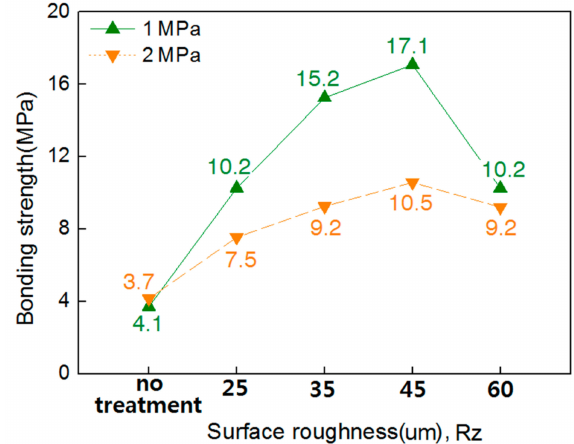
Figure 8. Bonding strength of CFRP/CR980 hybrid composites with different surface roughness conducted by hot compressing under different pressures.